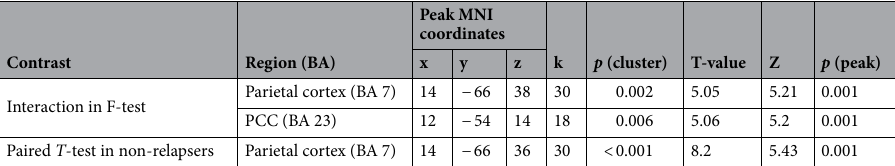
Table 2. Significant discontinuation relapse effects for the dorsolateral prefrontal cortex. BA Brodmann area, MNI Montreal Neurological Institue, PCC posterior cingulate cortex.